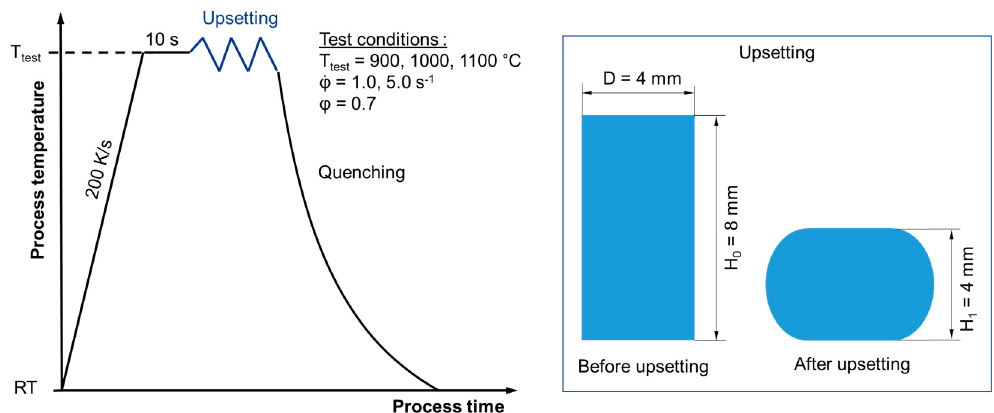
Figure 15. Test procedure (left) and sample geometry (right) for upsetting tests.